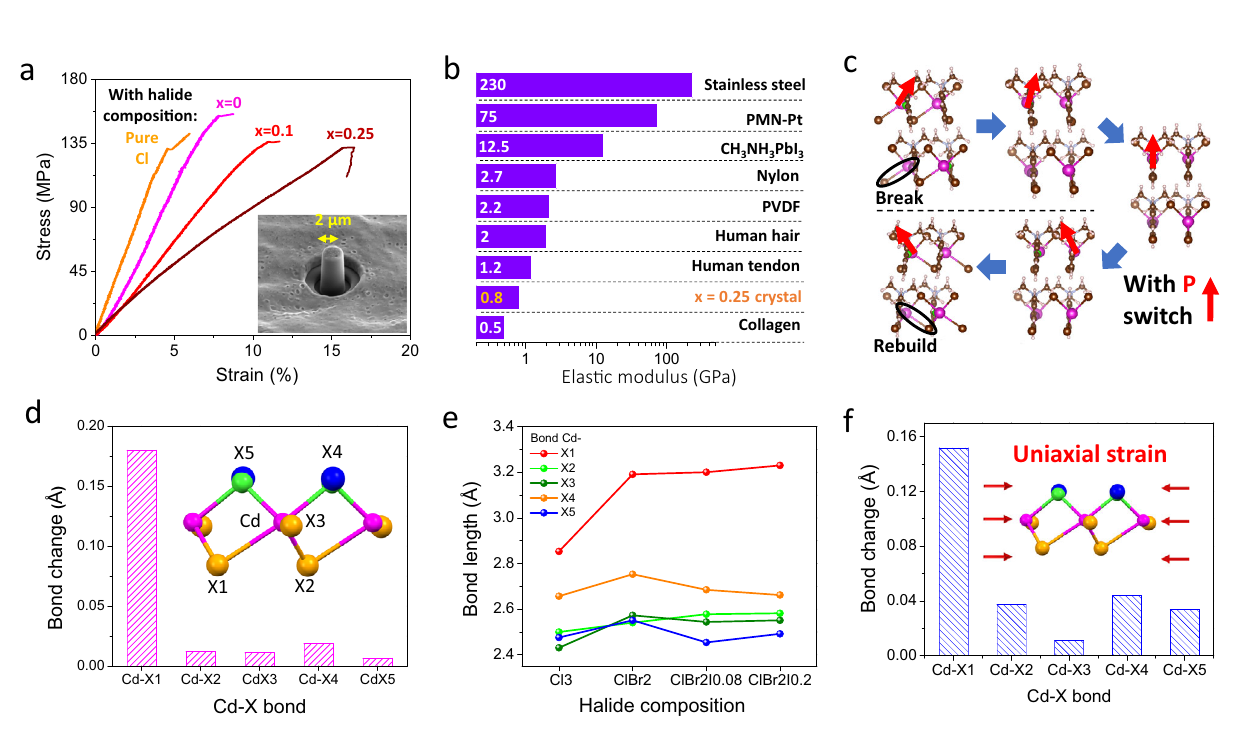
Fig. 4 | Mechanical properties and mechanism. a Strain-stress curves of C 6 H 5 N(CH 3 ) 3 CdX with different halide compositions. Inset: scanning electron microscope (SEM) image of a representative pillar for test. b Softness comparison of different materials and biological tissues. c Breaking and rebuilding of Cd-X1